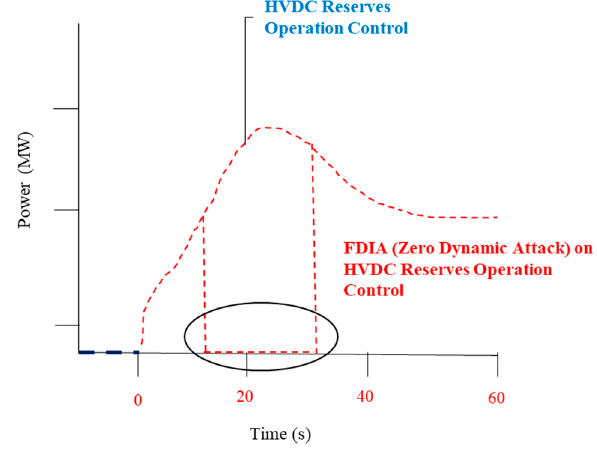
Figure 10. False data injection attack during E-FCR operation control.